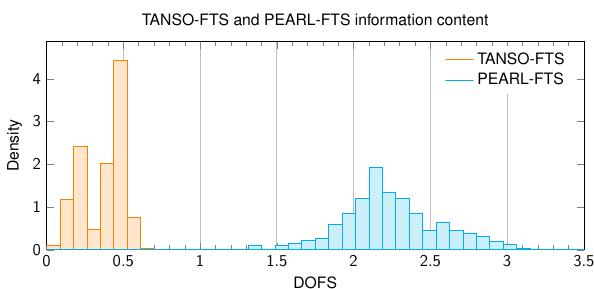
Figure 3. Histogram of the total DOFS per retrieved profile for the set of collocations between PEARL-FTS and TANSO-FTS. The histograms are normalized such that the total area for each his- togram equals 1.